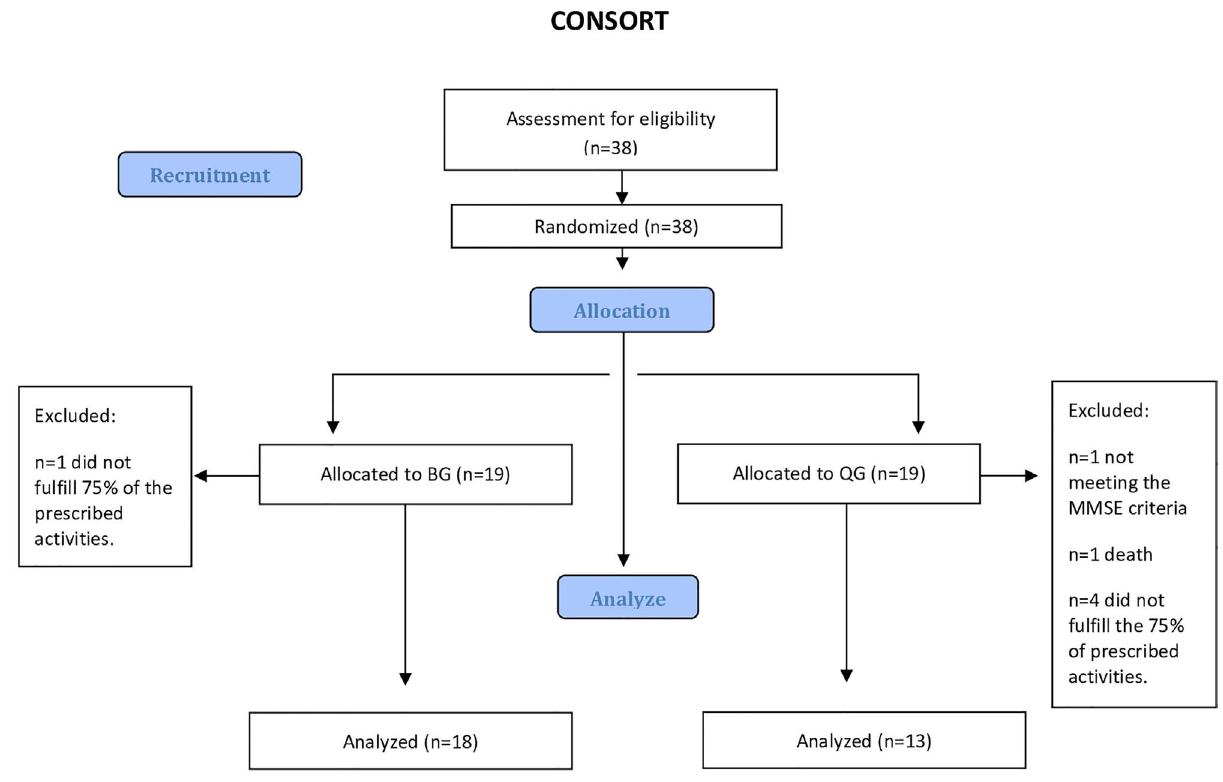
Figure 1 - Flowchart of the participant selection process and protocol steps.